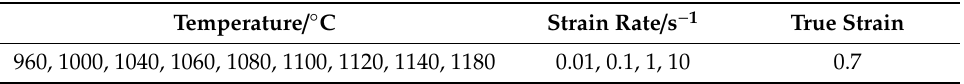
Table 2. Hot-deformation conditions of HY282 alloy